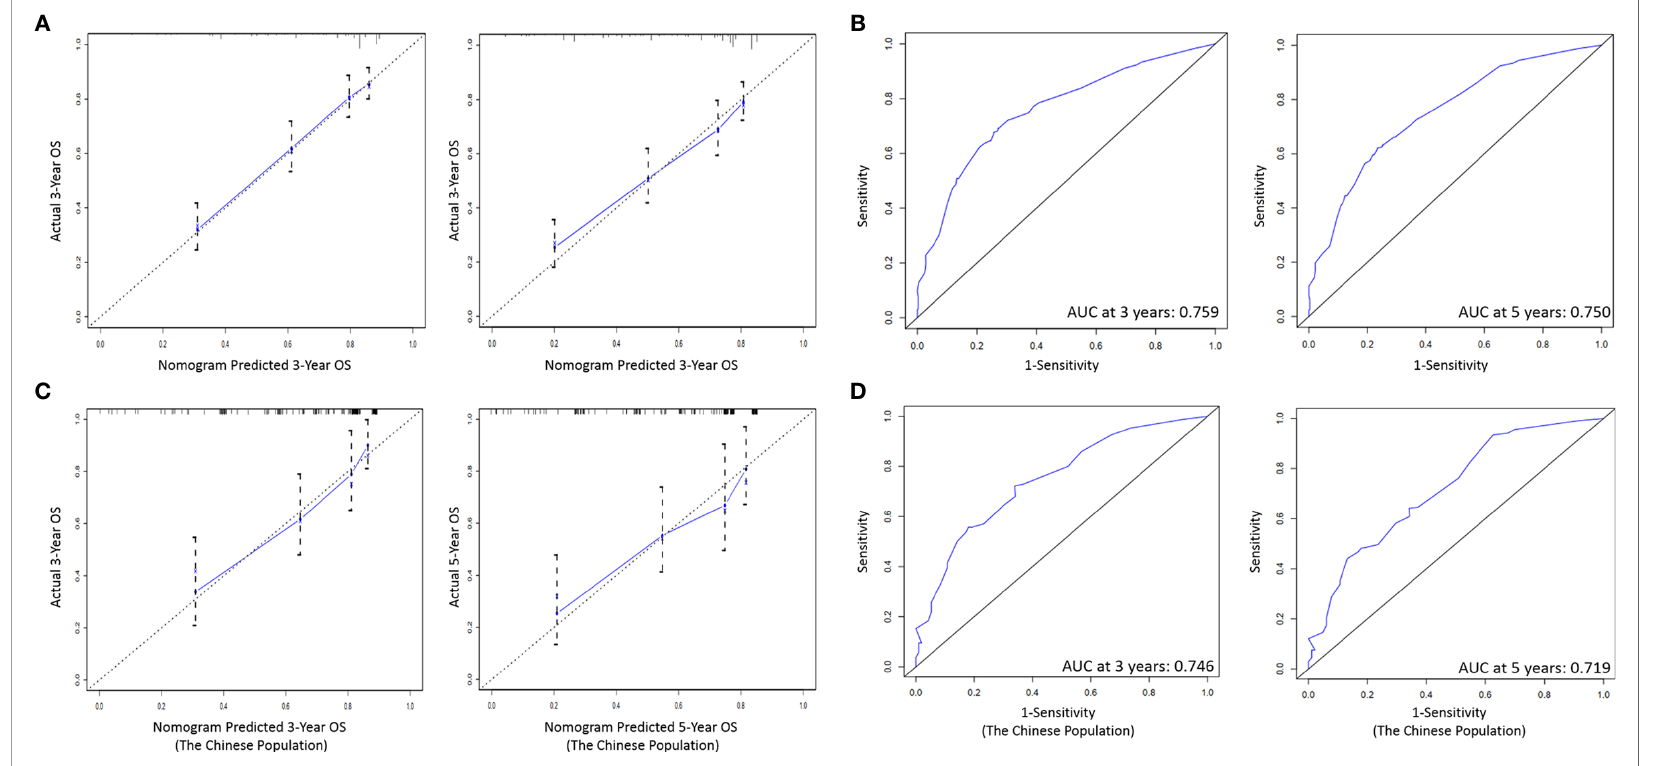
FIGURE 6 | (A) Calibration curves of the prognostic nomogram for 3-, and 5-year OS in the training set. (B) The ROC curve of the prognostic nomogram in the training set. (C) Calibration curves of the prognostic nomogram for 3-, and 5-year OS in the validation set. (D) The ROC curve of the prognostic nomogram in the validation set. ROC, Receiver operating characteristic; OS, Overall